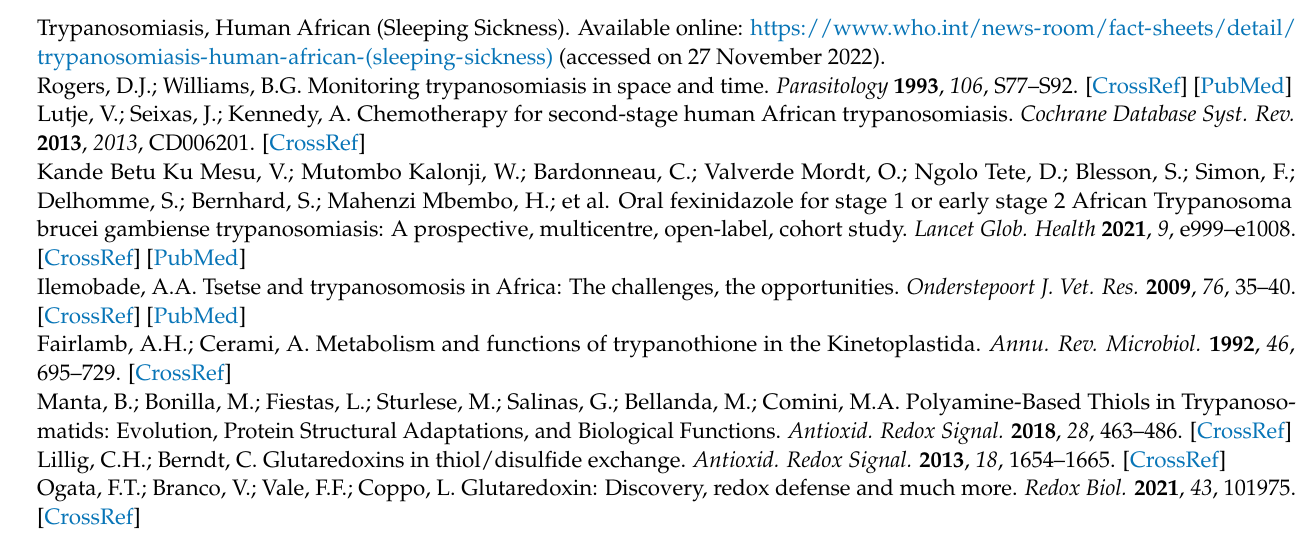
Figure S2: sequence comparison between T.b. 1CGrx1 and E. coli Grx4; Figure S3: Structure of the virtual